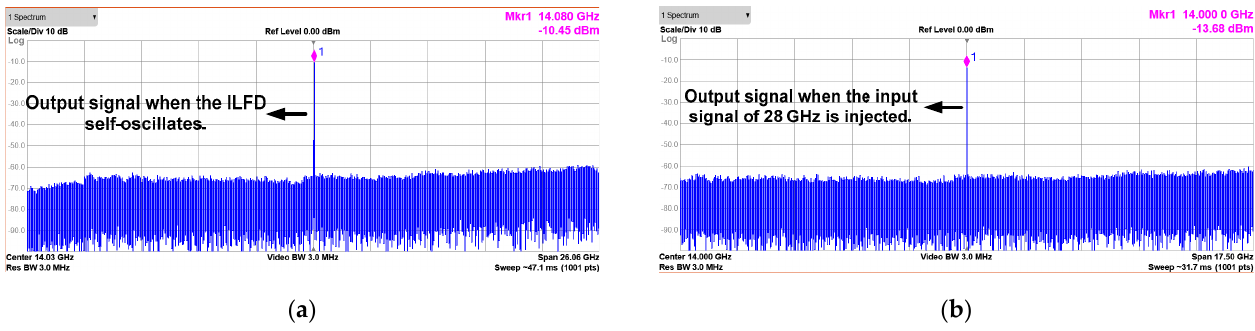
Figure 13. ( a ) Measured maximum and minimum operation frequency of the proposed CR-ILFD with different V inj,DC ; ( b ) Measured phase noise of input and output signal.